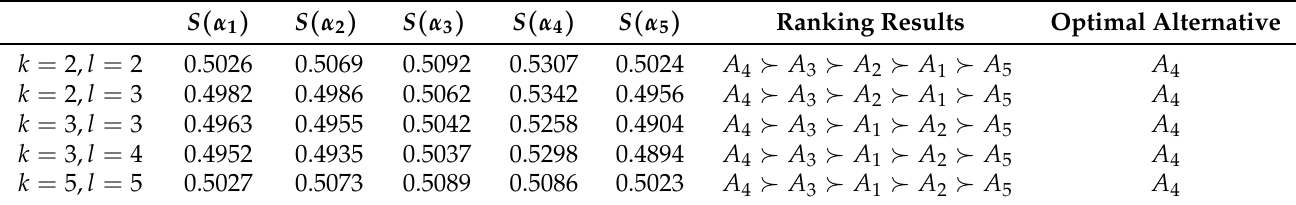
Table 4. Ranking results of the TSFWIBM operator.